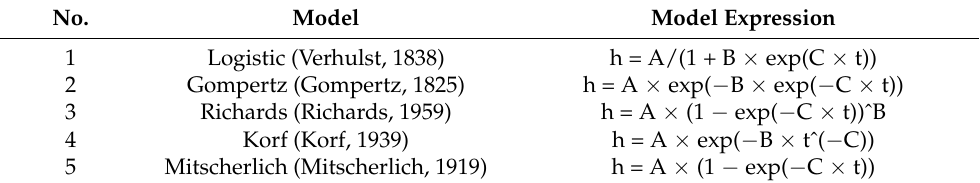
Table 4. Theoretical growth